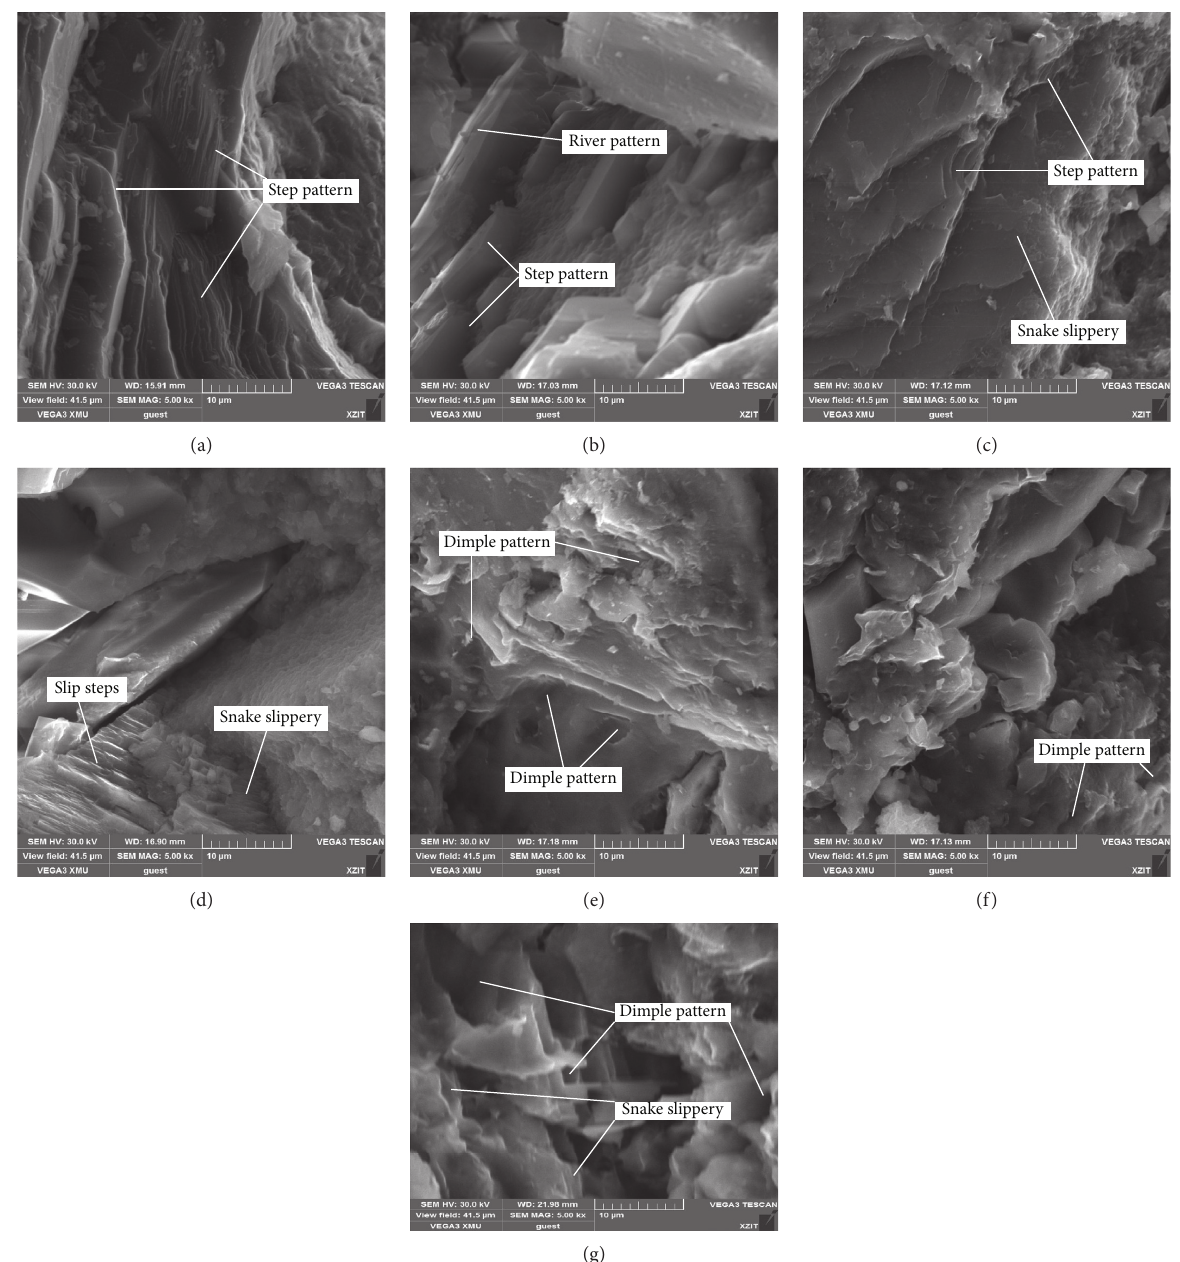
Figure 15: Sandstone fracture morphology with different moisture contents at 5000 times magnification: (a) ω � 0%, (b) ω � 2.01%, (c) ω � 2.23%, (d) ω � 2.40%, (e) ω � 2.49%, (f) ω � 2.53%, and (g) ω �